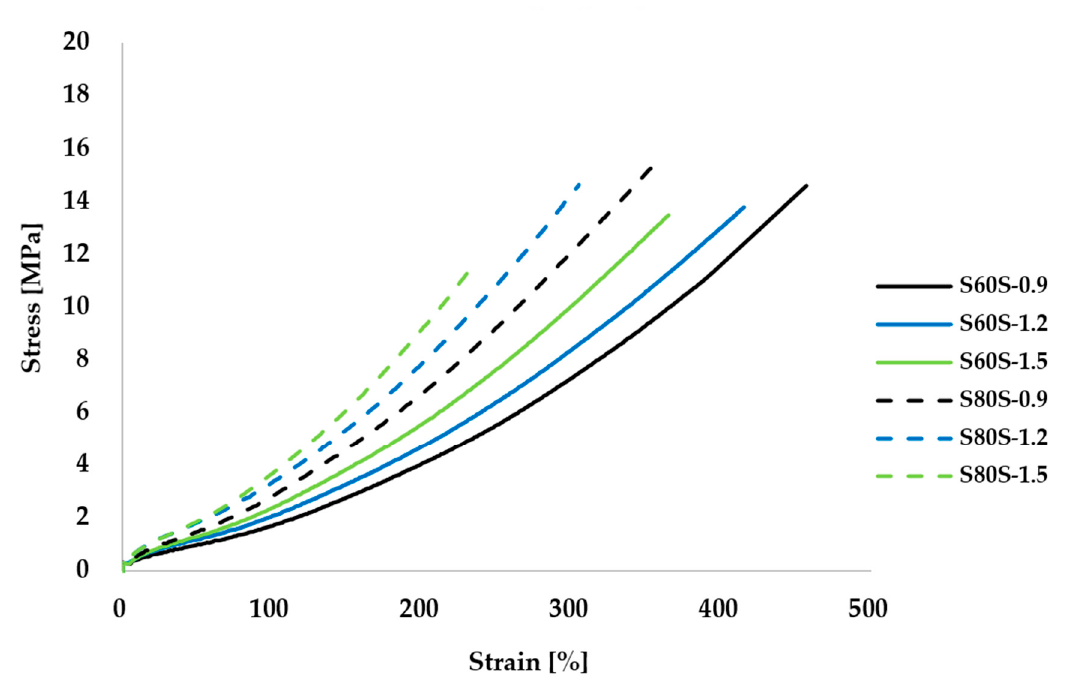
Figure 1 . Stress–strain curves of the vulcanizates Figure 1. Stress–strain curves of the